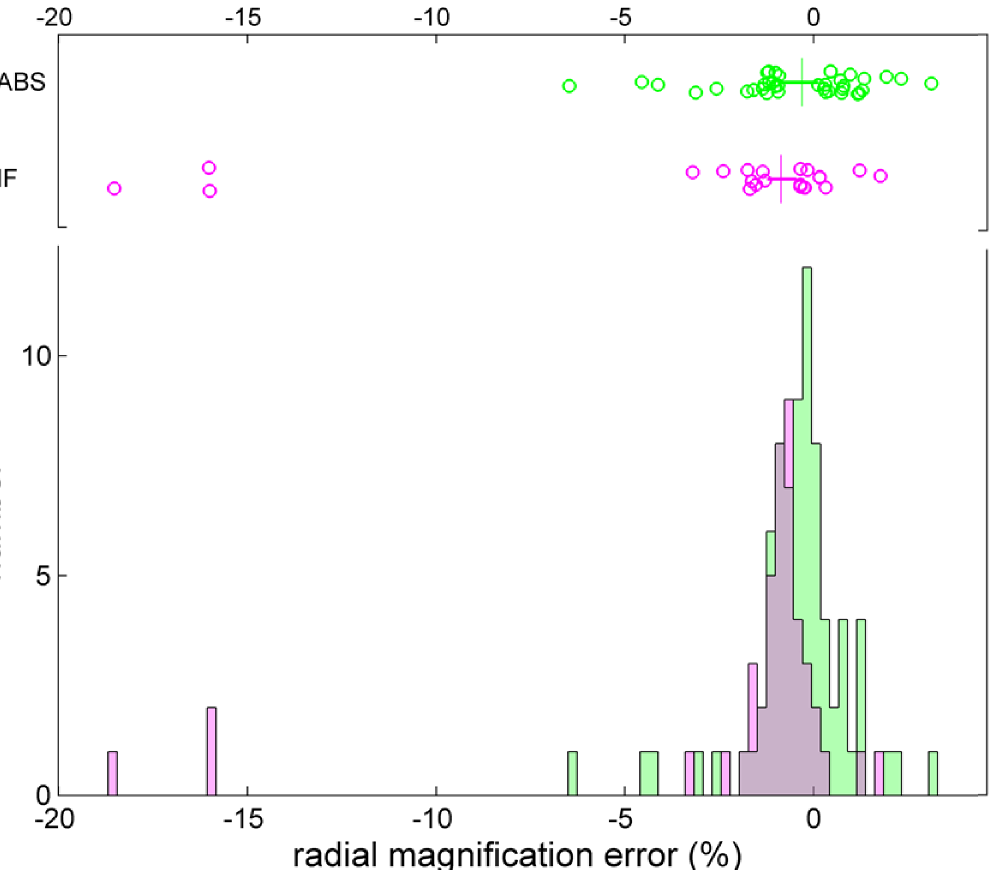
Fig 3. Magnitude of the radial magnification correction obtained with the absorbance system (green) and the interference system (magenta). The box-and-whisker plot above the histogram indicates the central 50% of the data as solid horizontal line and draws data in the smallest and highest 25% percentiles as individual circles. The median is displayed as vertical line. The mean and standard deviations are -0.43% ± 1.36% for the absorbance system, and -0.75% ± 0.82% for the interference system (once the three outliers are excluded).